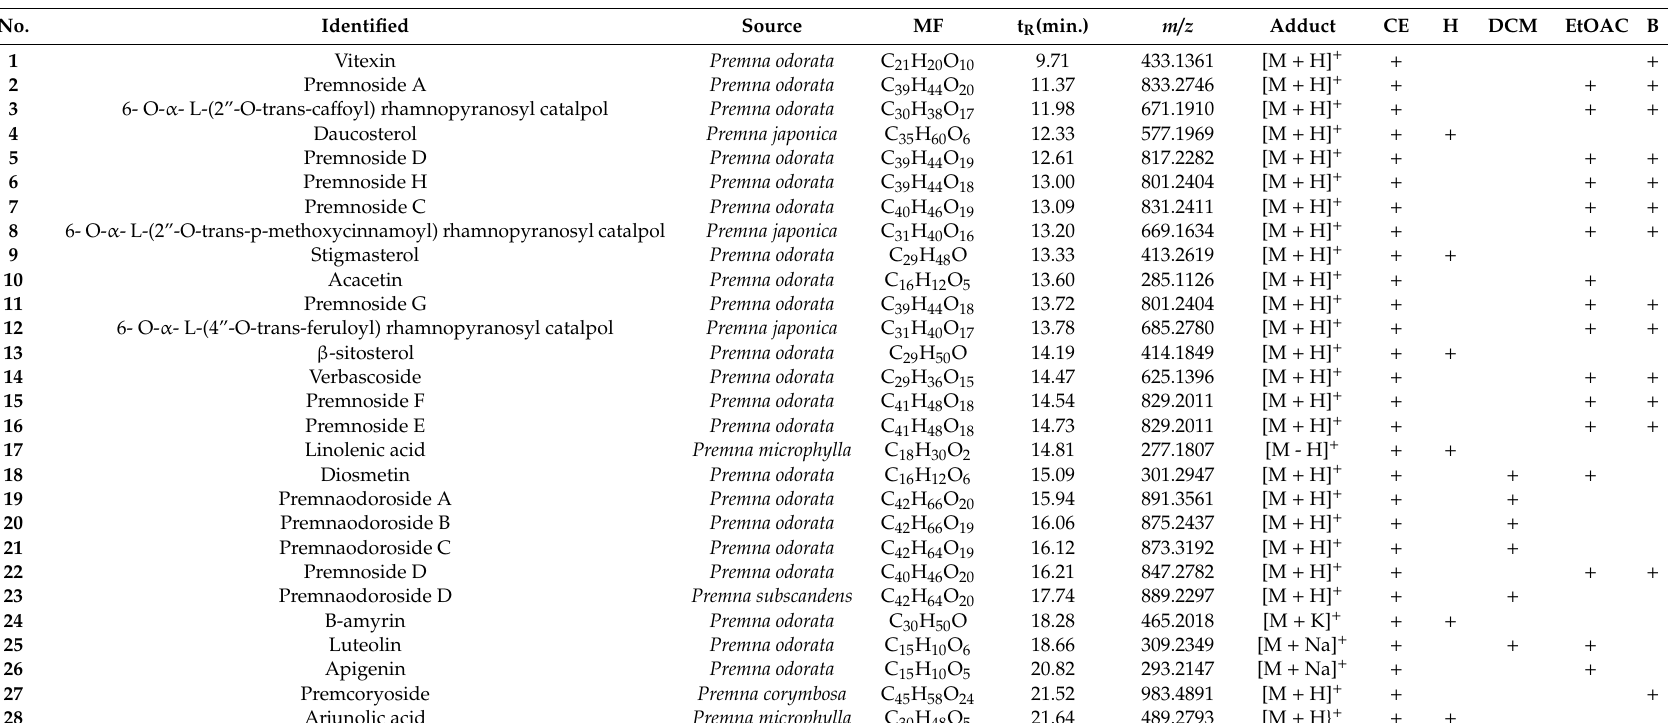
Table 1. The liquid chromatography / high-resolution electrospray ionization mass spectroscopy (LC–HRESIMS) dereplication results of the crude Premna odorata leave extract and fractions (n-hexane, dichloromethane, ethyl acetate,